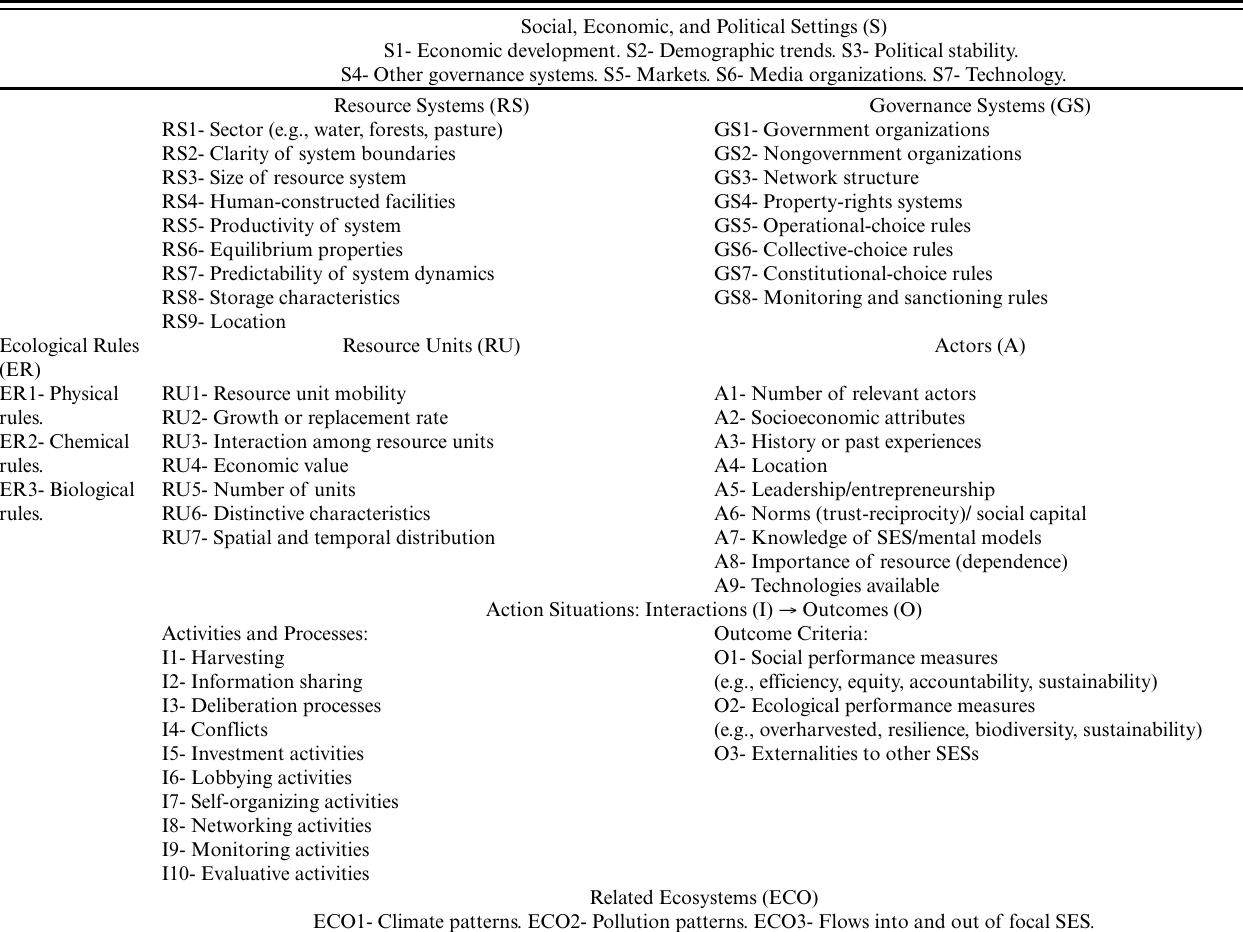
Table 1 . Attributes of subsystems of the social-ecological system (SES) framework. Table is from Epstein et al. (2013) and is used